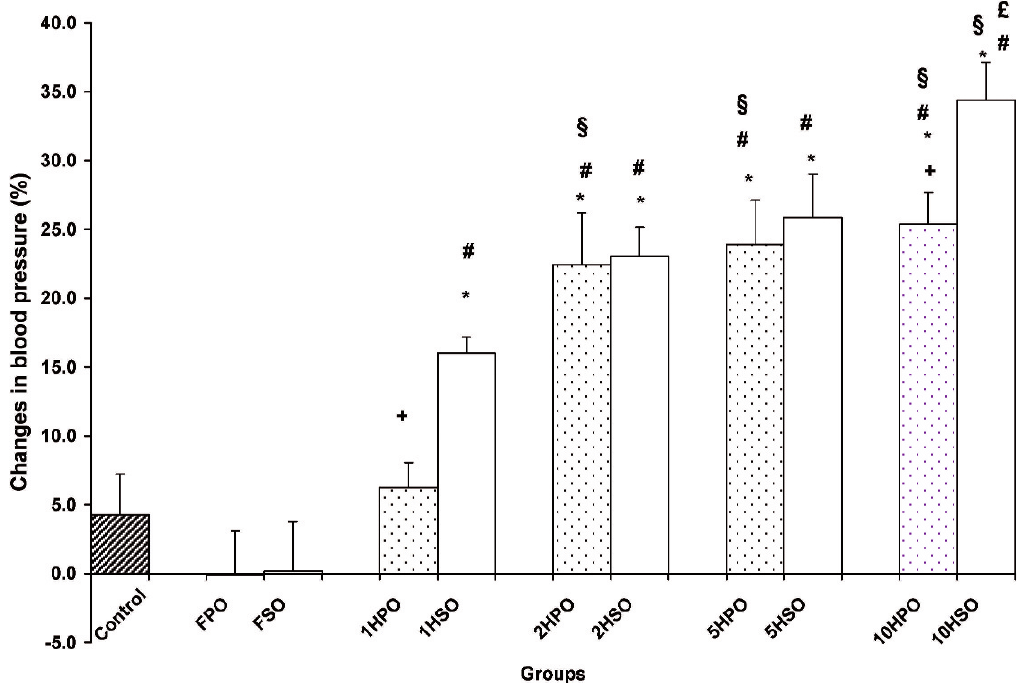
Figure 1 - Changes in blood pressure after 24 weeks of feeding with a basal diet (control) or chow amended with one of the following oils: fresh palm oil (FPO); palm oil that was heated once (1HPO), twice (2HPO), five times (5HPO), or ten times (10HPO); fresh soy oil (FSO); or soy oil that was heated once (1HSO), twice (2HSO), five times (5HSO), or ten times (10HSO). The results are the means ¡ SEM (n=10) . Significant difference ( p , 0.05) versus the * control, # fresh oil group, 1 once-heated-oil group, or £ twice-heated-oil group. + Significant difference ( p , 0.05) between the palm and soy oil groups. The data are expressed as percentage based on baseline